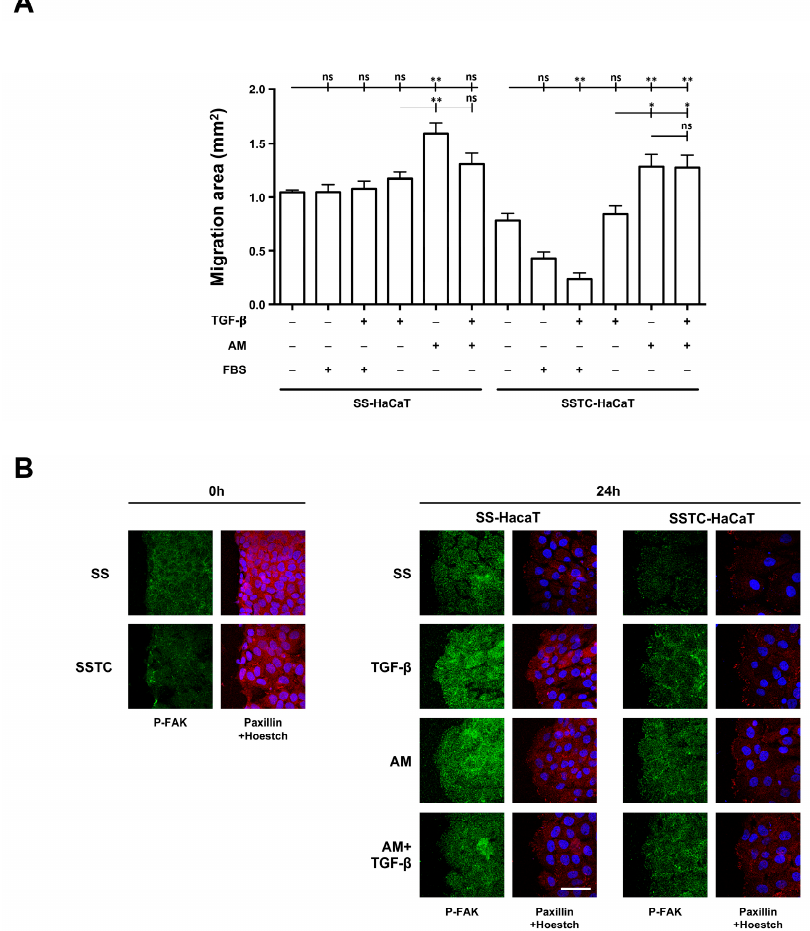
Figure 3. Exposure to amniotic membrane empowers migration capabilities and FA dynamics in keratinocytes persistently exposed to TGF- β . ( A ) Quantification of the migratory performance of SS-HaCaT and SSTC-HaCaT with regard to the initial gap area and the presence of adjuvant treatments. Replicates from three independent experiments were analyzed. Shown data represent the mean ± SEM. Asterisks denote statistically significant differences (* p < 0.05, ** p < 0.005). ( B ) Spatial and temporal patterns for the structural protein paxillin (red) and the activated modulator factor phosphorylated-FAK (green) in relation to SS-HaCaT and SSTC-HaCaT cell conditions and the exposure to adjuvant treatments. Nuclei are colored blue. Representative images of at least three independent experiments are shown. The scale bar equals 50 µm; ns, non-signi fi cant.